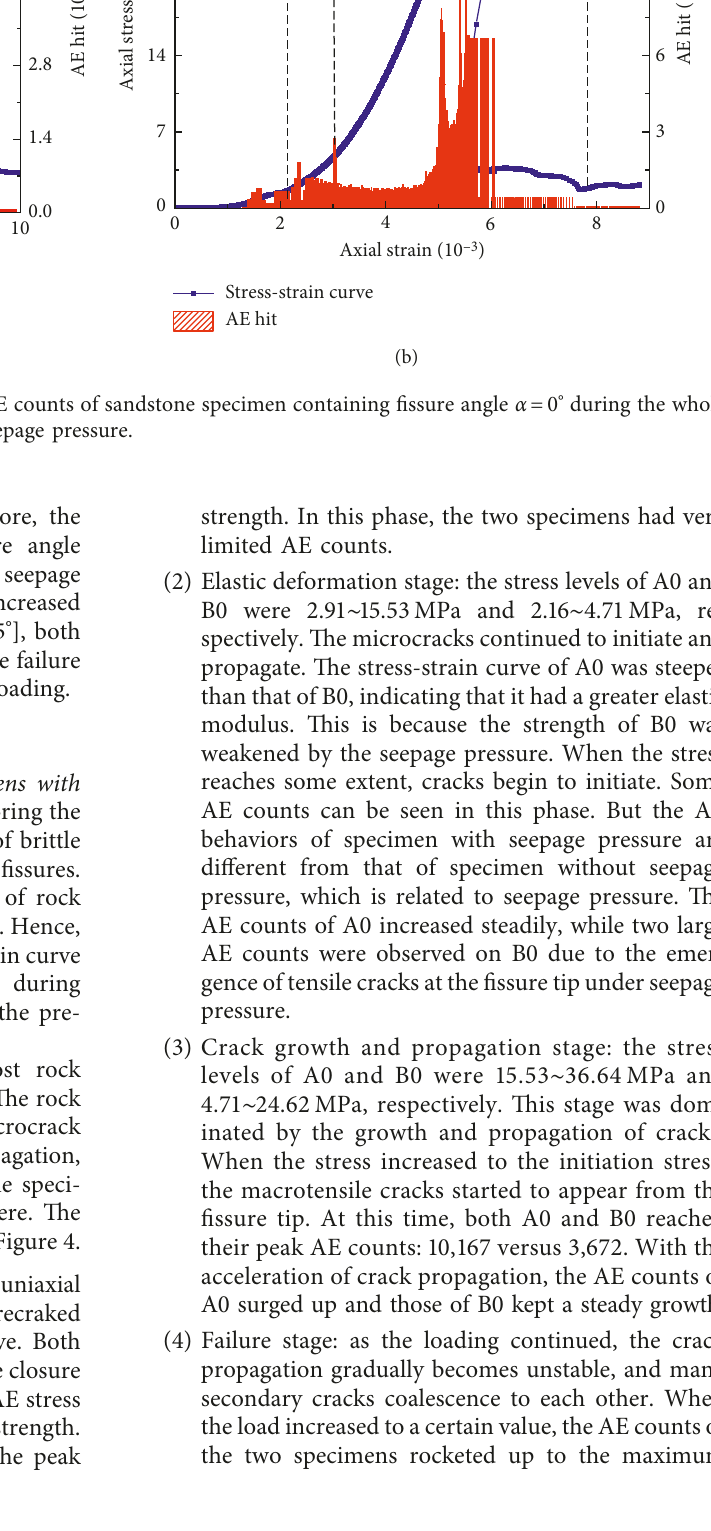
0 ° during the whole (cid:31)